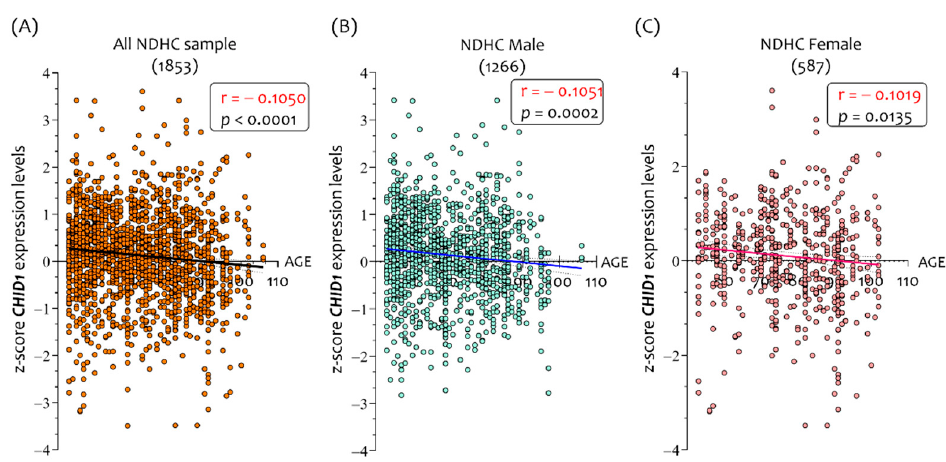
Figure 2. Correlation analysis between CHID1 brain expression levels and the age of NDHC subjects. Correlation analysis between CHID1 and the age of NDHC subjects ( A ), sorted according to the sex in brain samples of 1266 males ( B ) and 587 females ( C ). Data in the figure are indicated as z-score intensity expression levels and presented graphically as dot plots. p values < 0.05 were considered to be statistically